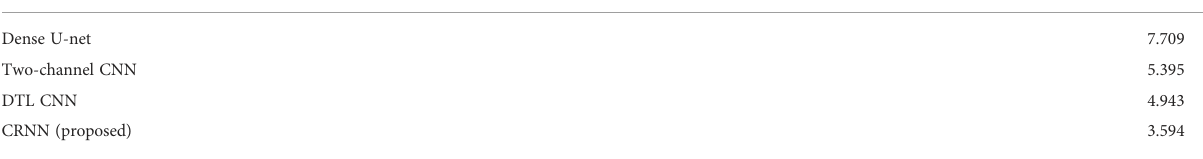
TABLE 5 Performance comparison of deep learning-based methods on real data.